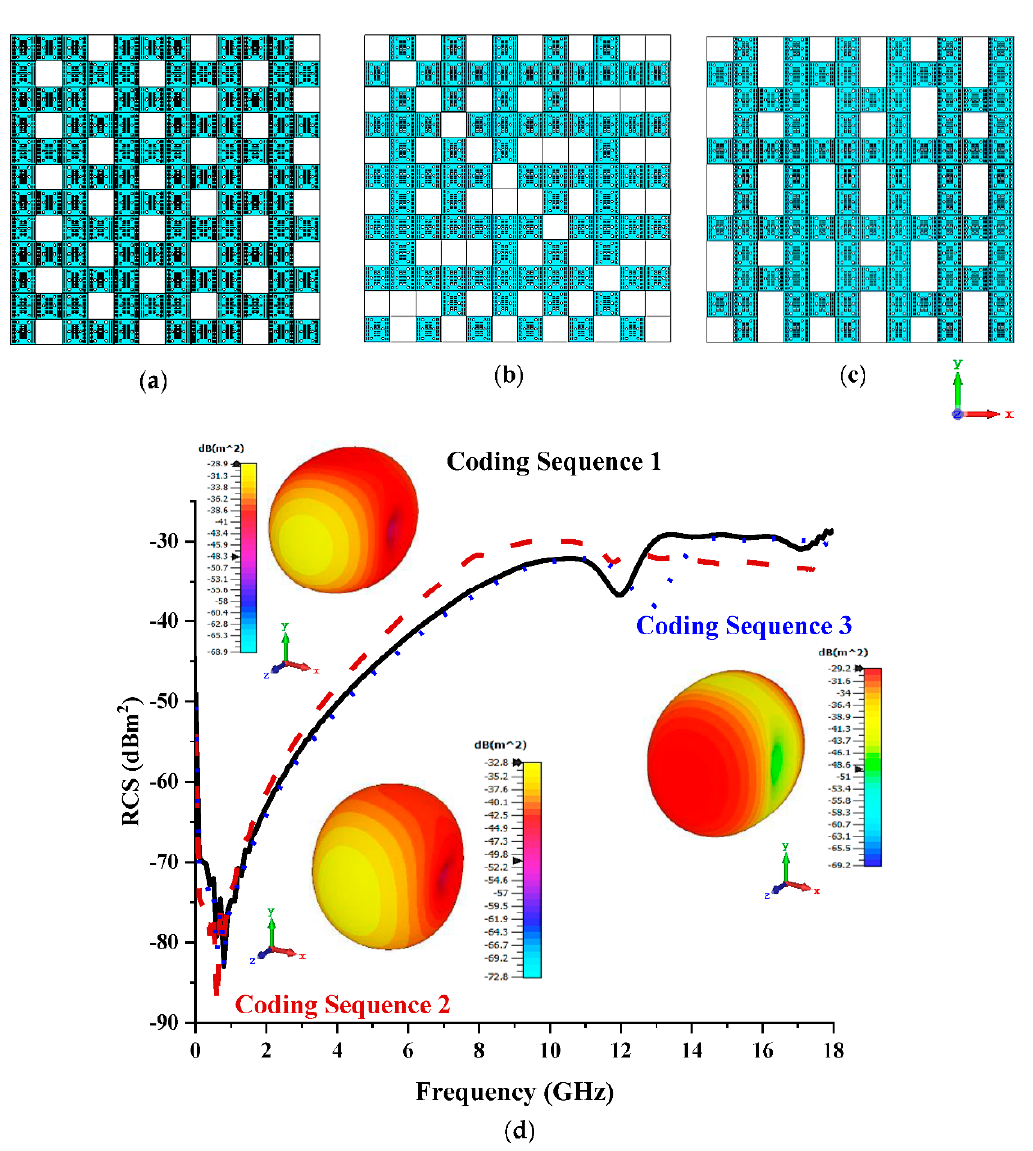
Figure 4. Twelve lattices: ( a ) Coding Sequence 1; ( b ) Coding Sequence 2; ( c ) Coding Sequence 3; ( d ) monostatic RCS and bistatic scattering pattern at 15 GHz.